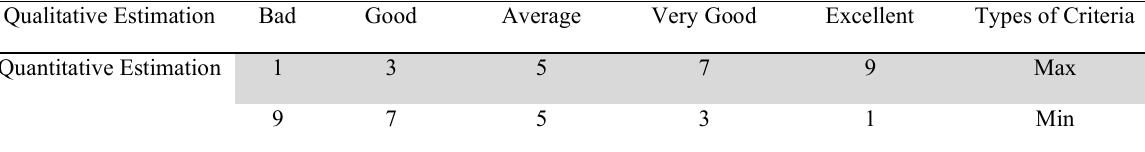
Hwang and Yoon Comparison Scale Qualitative Estimation Bad Good Average Very Good Excellent Types of Criteria Quantitative